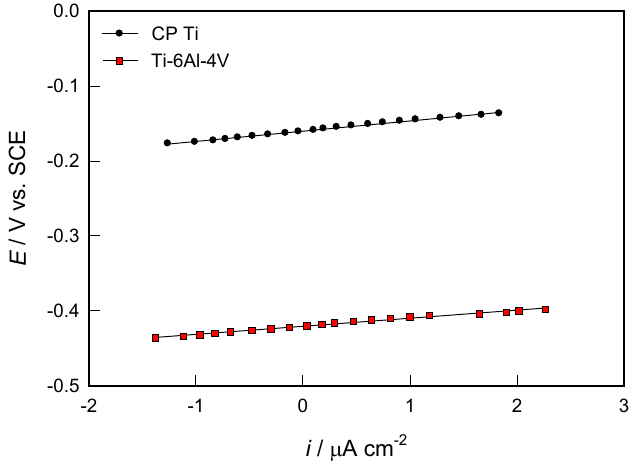
Figure 2. Linear parts of polarization curves for CP Ti and Ti-6Al-4V alloy in PBS solution. Performing potentiodynamic polarization measurements is particularly interesting to examine the anodic behavior of a corroding system. The potential of the sample changes slowly in the positive direction, due to which it acts as an anode and corrodes or an oxide layer is formed on it. To investigate the stability of the protective surface oxide film on CP Ti and Ti-6Al-4V alloy at high anodic potentials, potentiodynamic polarization measurements were performed in the potential range from − 0.4 V vs. E OC up to 2.0 V. The representative polarization curves obtained for both CP Ti and Ti-6Al-4V alloy in the PBS solution is displayed in Figure 3. On the anode branch of polarization curves (potentials more positive than corrosion potential, E corr ), two characteristic areas of potential are observed: